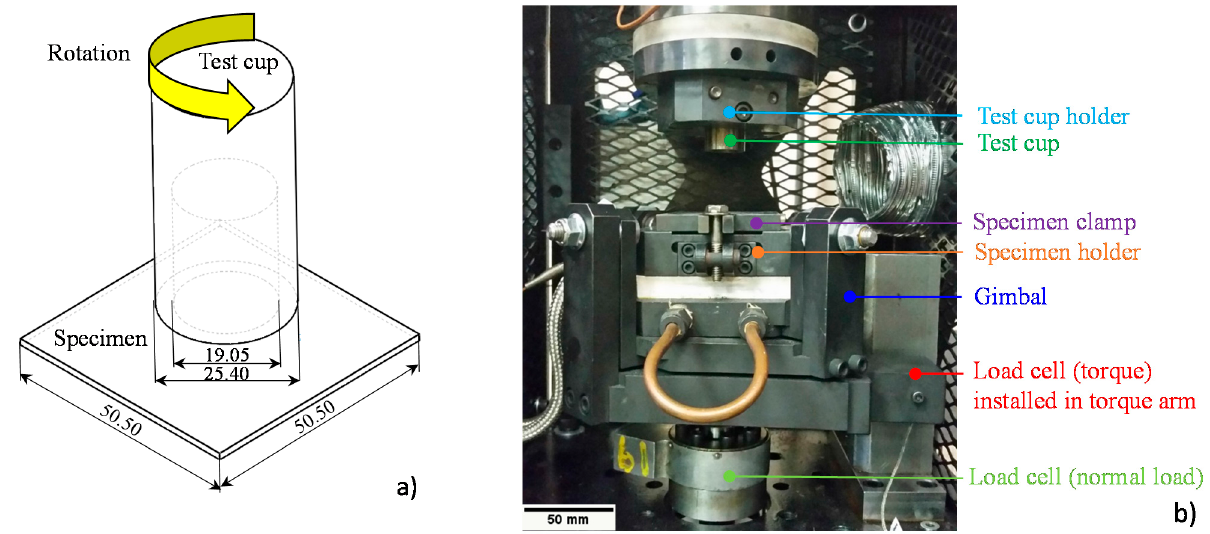
Figure 19. Schematic of the test methodology. Units are in mm. ( a ) and experimental set-up of the TCT. Units are in mm. ( b ).